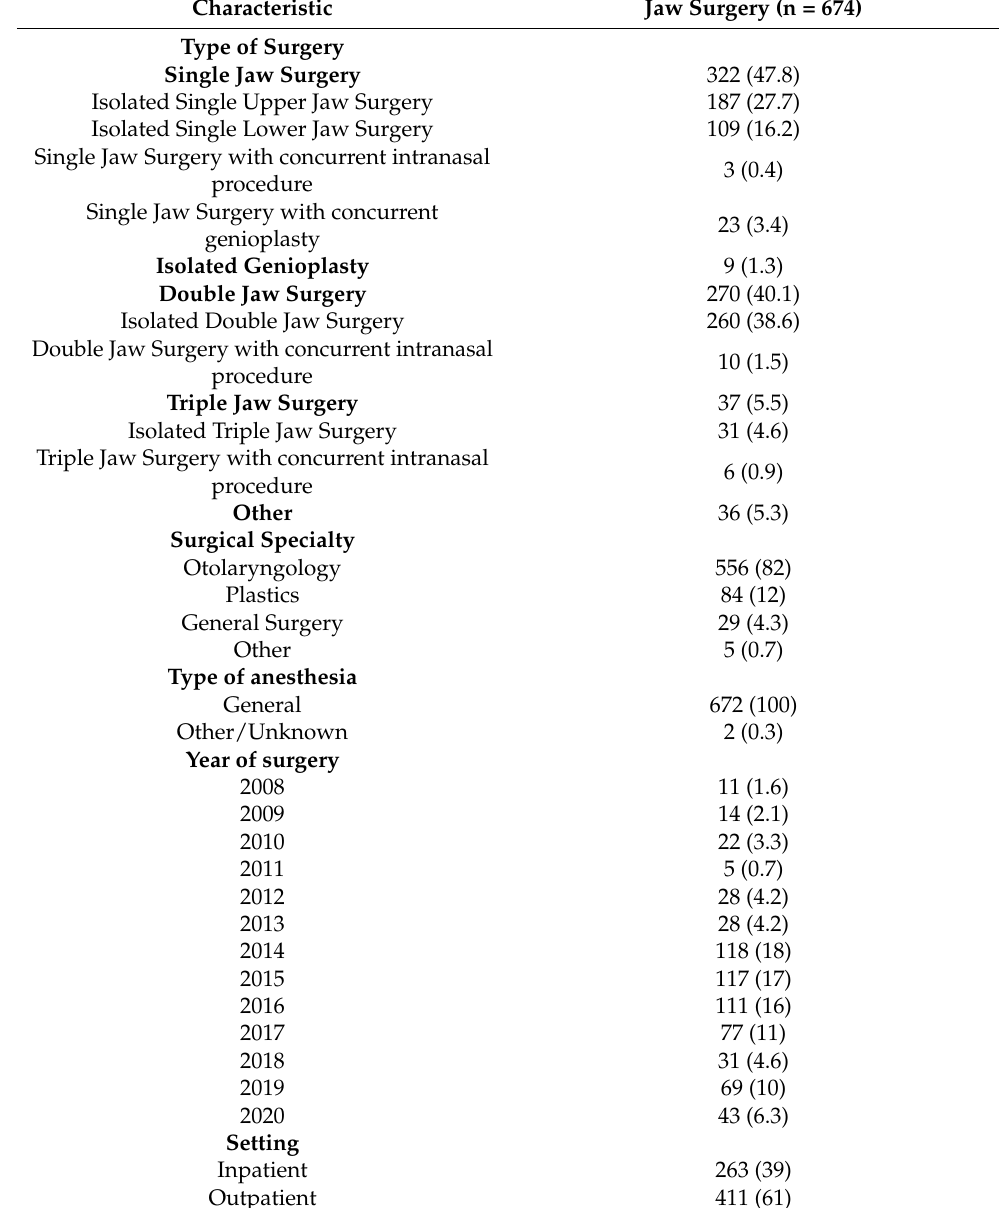
Table 3. Surgical characteristics. Reported as n